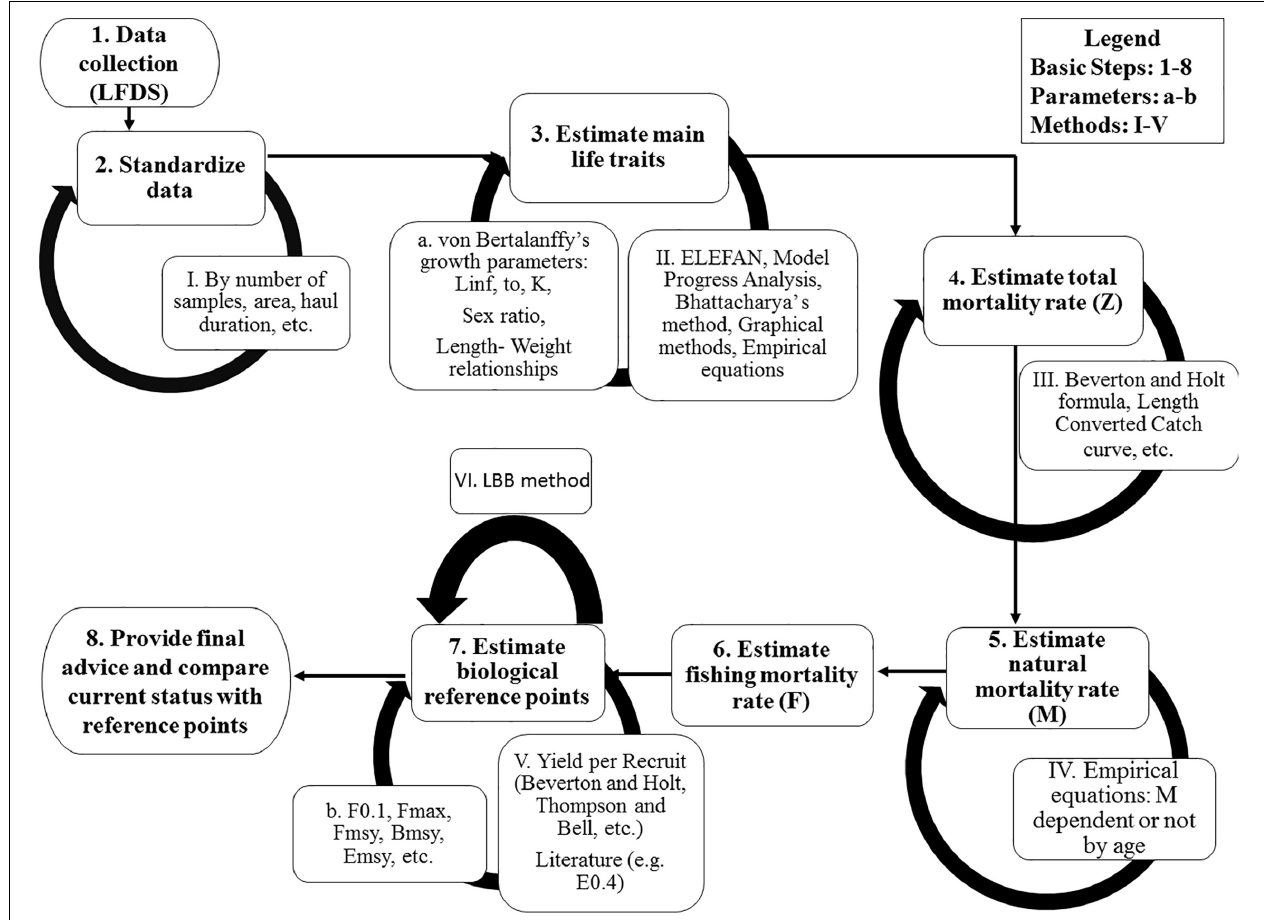
FIGURE 2 | The basic steps (1–8) to assess an extremely data-limited stock, with a selection of associated